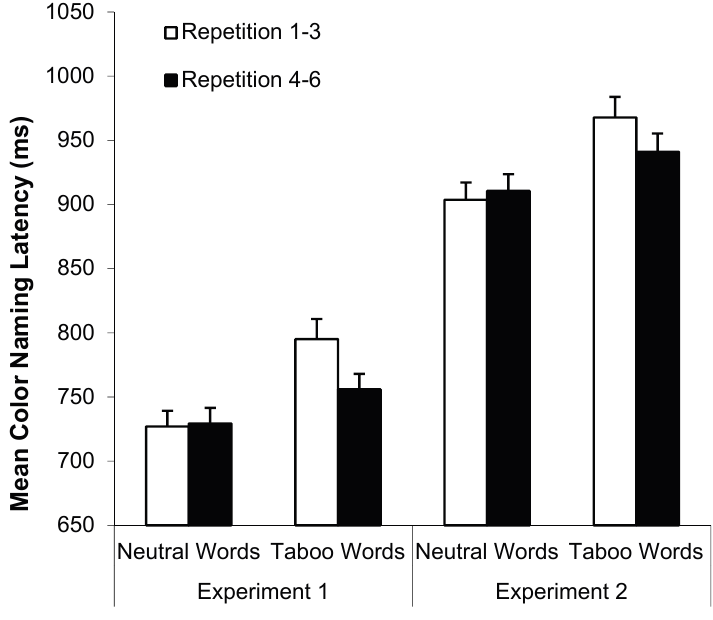
Figure 4. Mean color-naming RTs (+ SE ) as a function of word type and repetitions 1–3 vs. 4–6 in Experiments 1 (left panel) and 2 (right panel).